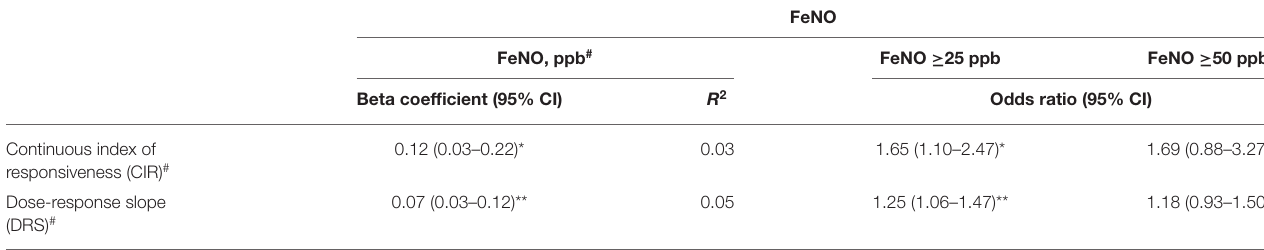
TABLE 2 | Association between continuous indices of bronchial hyperresponsiveness obtained from methacholine challenge and exhaled nitric oxide (FeNO).